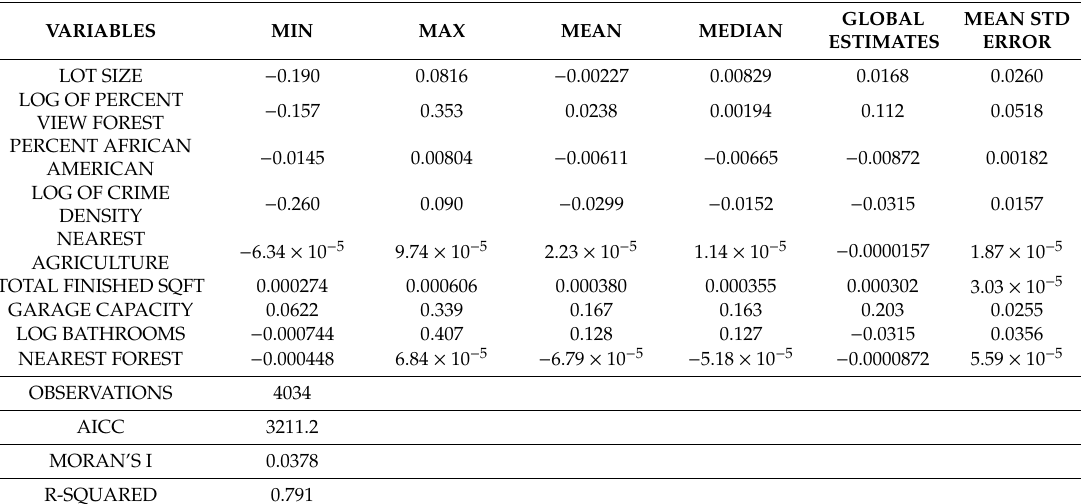
Table 4. Geographically weighted regression (GWR) results. The estimates from the global OLS regression are listed for comparison with GWR mean and median